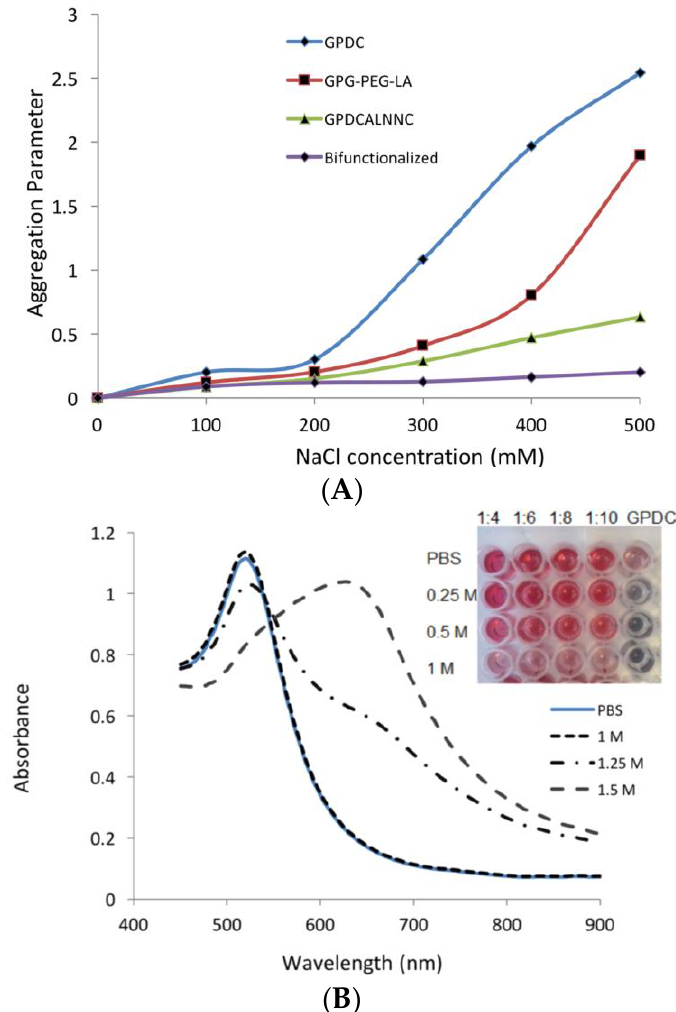
Figure 3. ( A ) Effect of introducing different stabilizing groups on the stability of Au NPs at different ionic strengths. The aggregation parameter is defined as follows: AP = (A − A 0 )/A 0 , where A is the integrated absorbance between 500 and 700 nm of the sample and A 0 is the integrated absorbance between 500 and 700 nm of the initial, fully dispersed solution of NPs. ( B ) UV-vis study of C/G-capped Au NP stability as a function of NaCl concentration. Inset: stability of C/G-capped Au NPs (1:4, 1:6, 1:8, and 1:10) compared to GPDC-capped Au NPs in NaCl solutions with various ionic strengths. As higher concentrations of the salt were added, a greater screening of charges stabilizing the modified Au NPs occurs, leading to the red shift of the absorption band and band broadening.